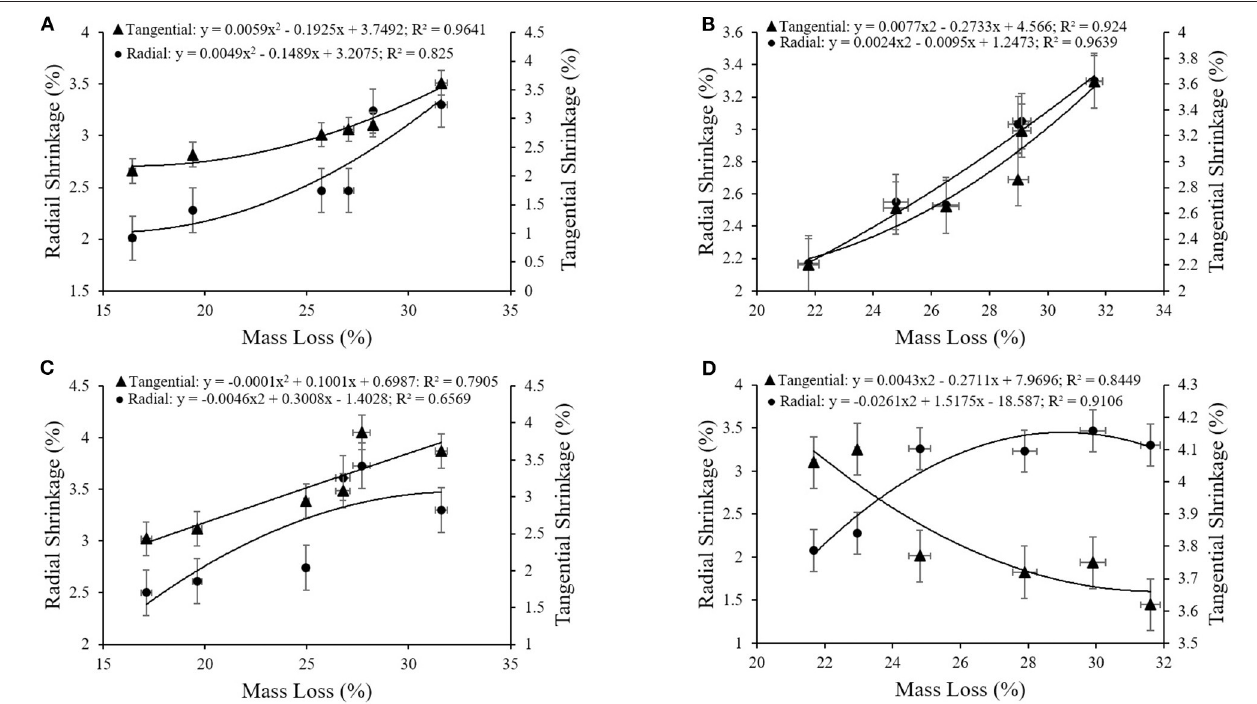
FIGURE 8 | (A–D) Relationship between the mass loss and tangential and radial shrinkages for (A) E1; (B) E2; (C) E3; (D) E4.